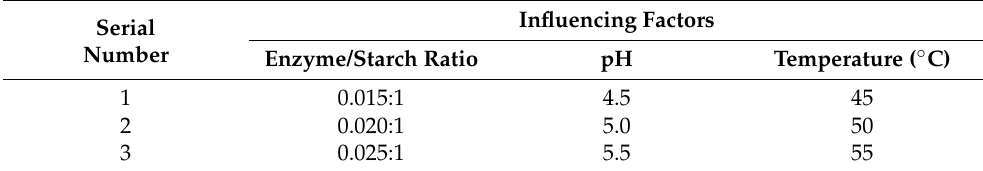
Table 1. Levels and factors of orthogonal